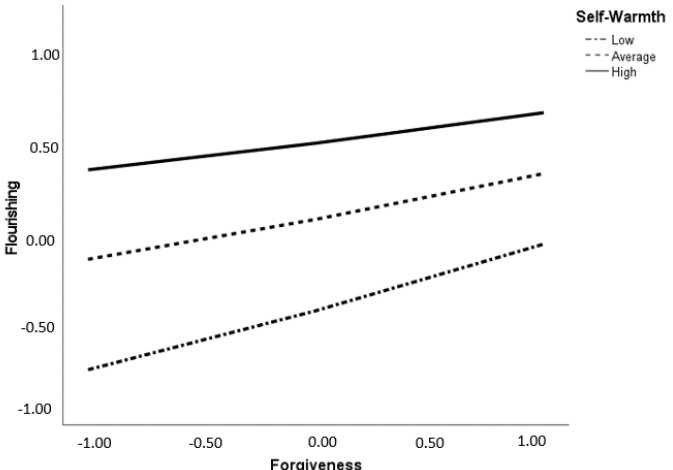
Figure 2. A visual representation of the moderation effect of forgiveness on flourishing at low, av- erage, and high levels of self-warmth. The graph shows standardized data. average, and high levels of self-warmth. The graph shows standardized